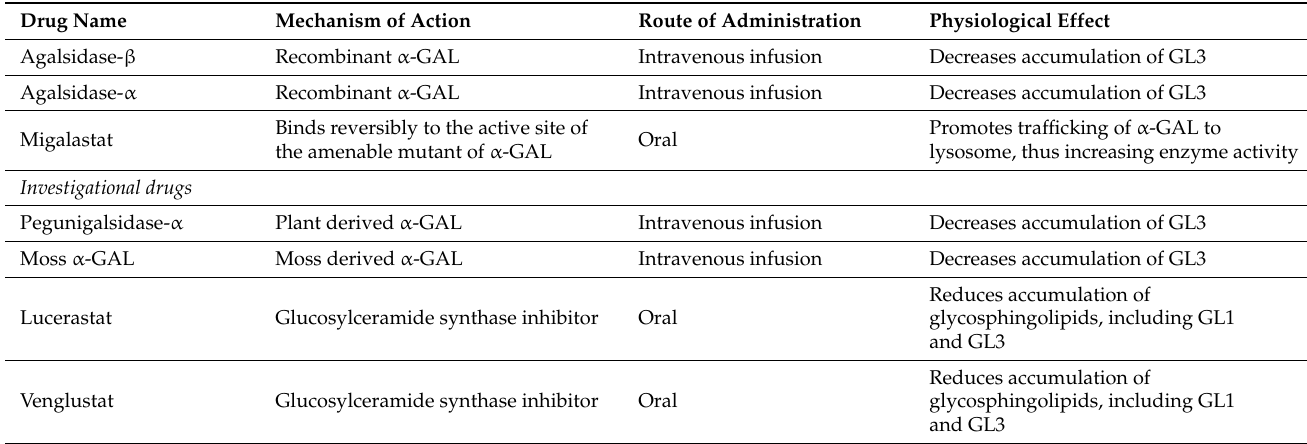
Table 2. Available and investigational drugs for the treatment of FD with their mechanism of action, route of administration, and physiological effects. α -galactosidase A ( α -GAL), glucosylceramide (GL1), globotriaosylceramide (GL3).